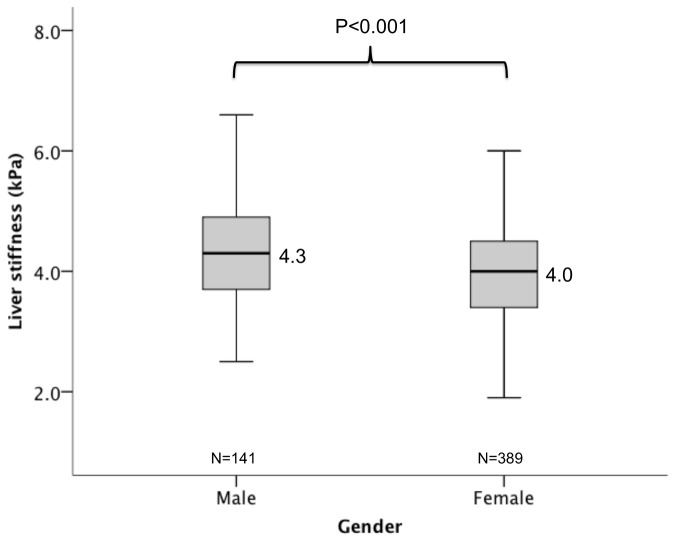
Liver stiffness according to gender.